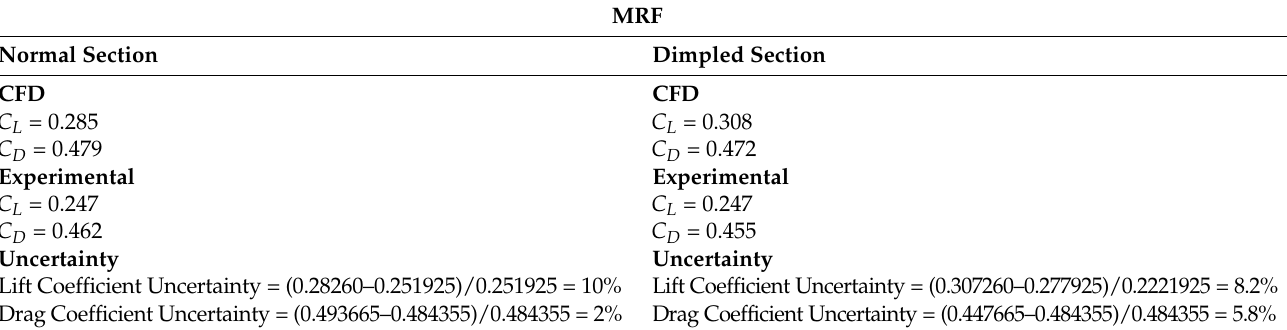
Table 4. Uncertainty calculations of both sections of the turbine blade at an optimum AOA for MRF.